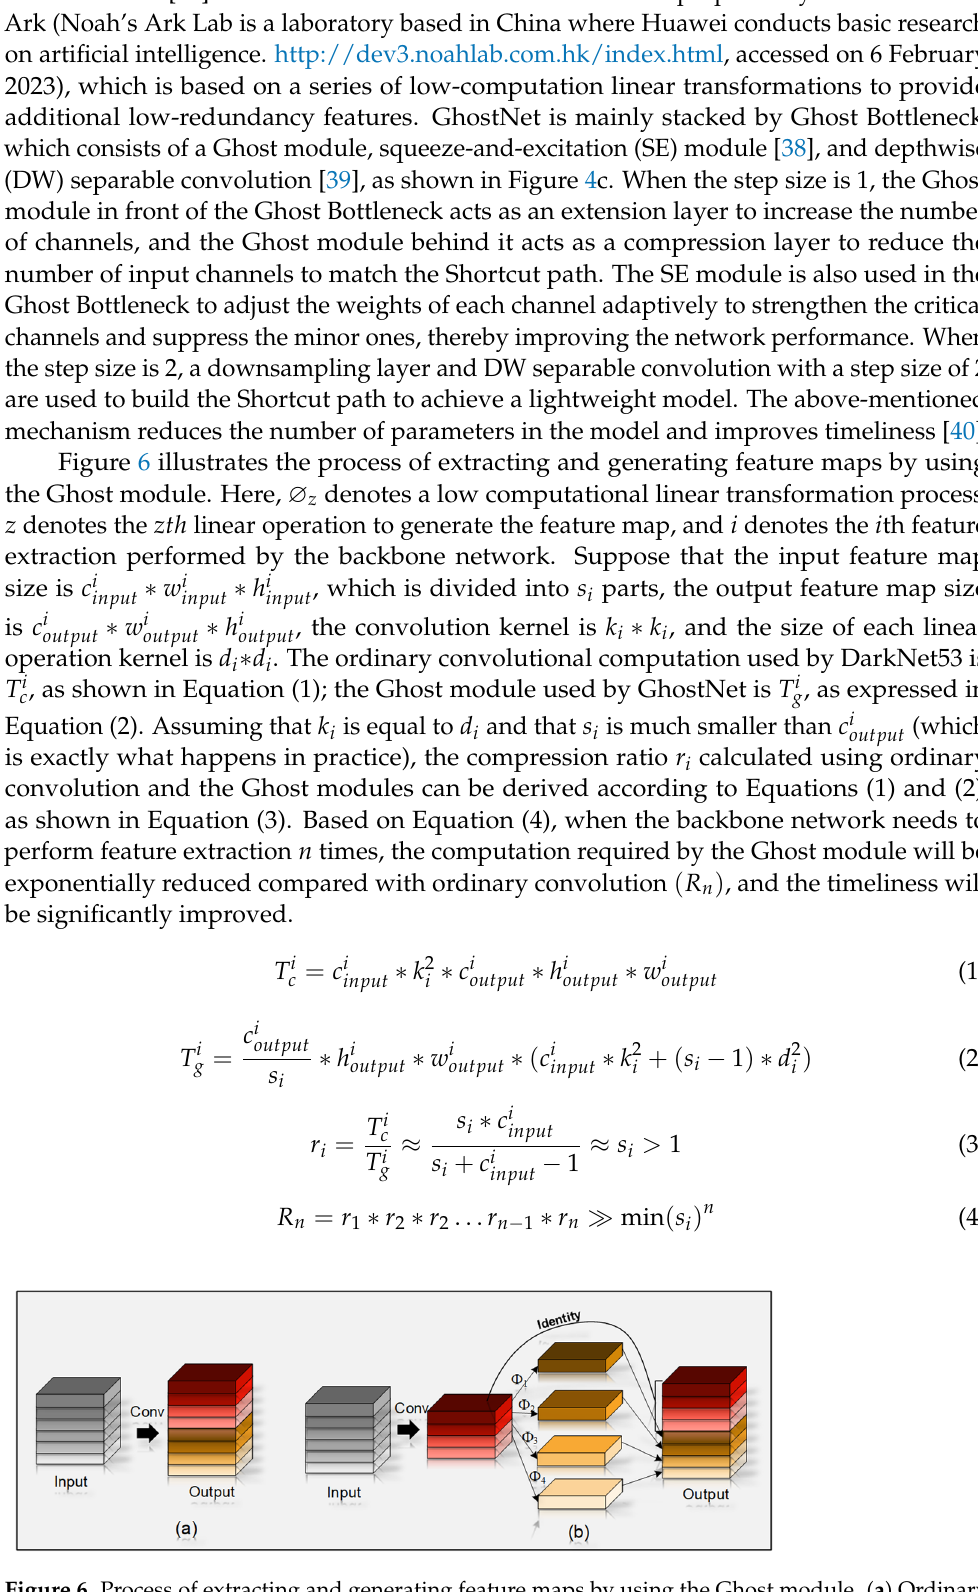
Figure 6. Process of extracting and generating feature maps by using the Ghost module. ( a ) Ordinary convolution; ( b ) Ghost module.